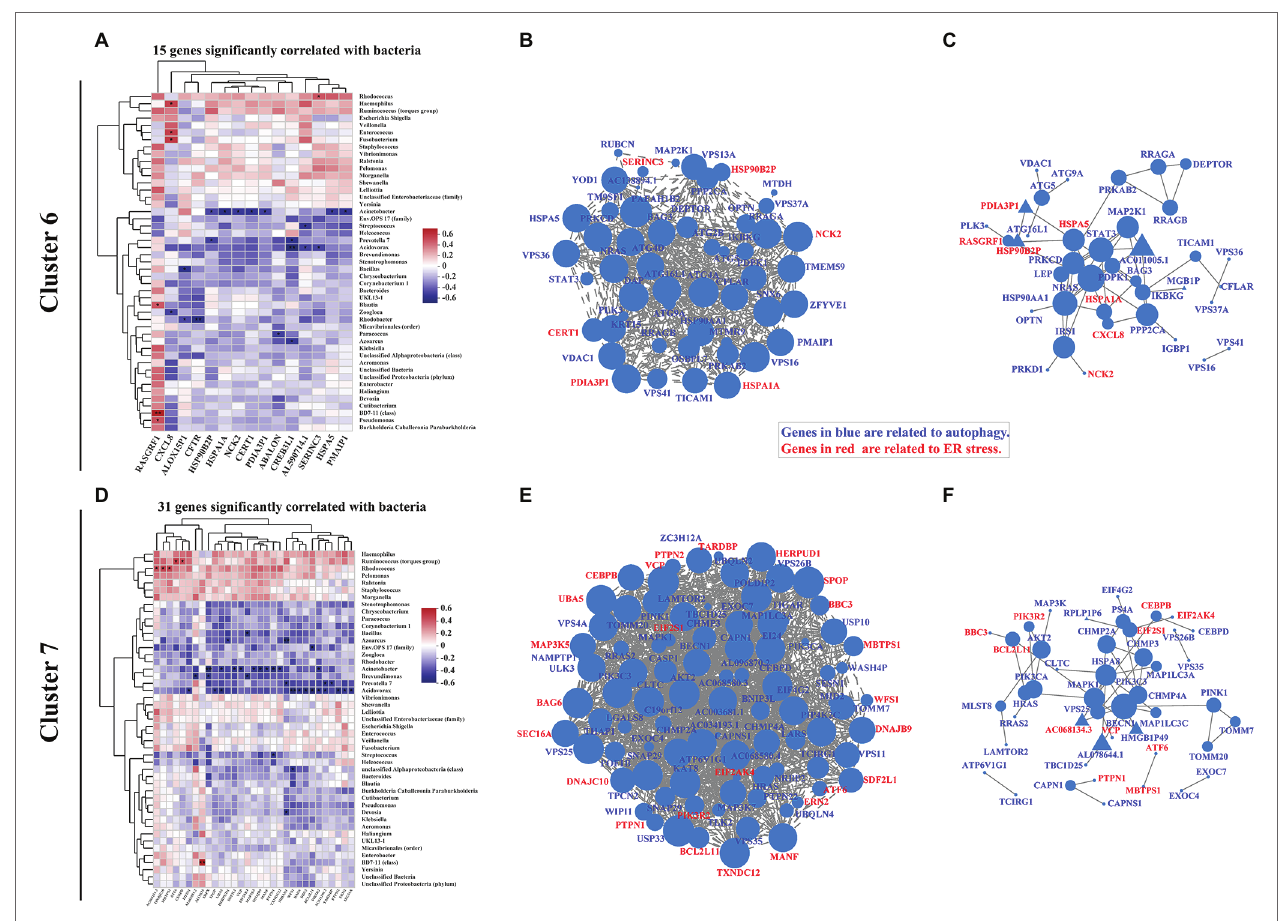
FIGURE 4 | Correlation pattern of endoplasmic reticulum (ER) stress with intestinal mucosa-colonizing bacterial community and autophagy signaling in IBD patients. Spearman correlation heatmap shows 15 ER stress-related genes in cluster 6 (A) and 31 ER stress-related genes in cluster 7 (D) were significantly correlated with intestinal mucosa-colonizing bacteria (top 47). All bacteria were named to genus level unless otherwise noted in brackets. * 0.01 < p ≤ 0.05, ** 0.001 < p ≤ 0.01, and *** p ≤ 0.001. Correlation network of both autophagy signaling and ER stress-related genes in cluster 6 (B) and cluster 7 (E) . Autophagy signaling genes and ER stress genes are labeled in blue and red, respectively. Circle area is positively correlated with number of connected genes. Correlation network was constructed based on Spearman rank correlation coefficients ( ∣ Spearman Coef ∣ ≥ 0.8, p < 0.05). Multiple testing correction: BH. Interaction network of autophagy signaling and ER stress genes in cluster 6 (C) and cluster 7 (F) . Circle or equilateral triangle areas are positively correlated with number of connected genes. Interaction between circle-labeled genes with others has been reported. Interaction between equilateral triangle-labeled genes with others was predicted based on primary structure of gene-coding proteins. Control population: n = 6; UC patient: n = 12; and CD patient: n =